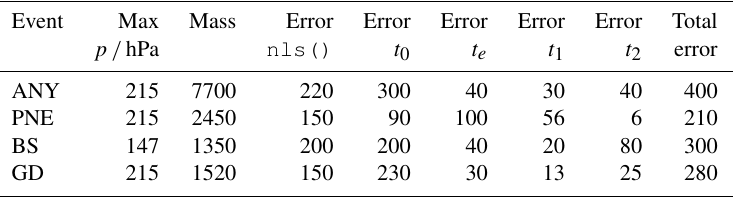
Table 1. Summary of the injected masses of CO due to the four fire events noted in the text, showing the best estimate of the total mass, with the pressure level in the “Max p ” column being the highest pressure (lowest altitude) level included. Contributions to the error in the mass estimate caused by the choice of the parameters t 0 , t e , t 1 and t 2 are shown. Also shown is a typical error as returned by the R function nls() . The total error is obtained by summing the five individual errors in quadrature. This procedure is not ideal as most of the errors will be correlated with each other. However, it gives a reasonable conservative estimate. Units are gigagrams for all data. Event Max Mass Error Error Error Error Error Total p / hPa nls() t 0 t e ANY